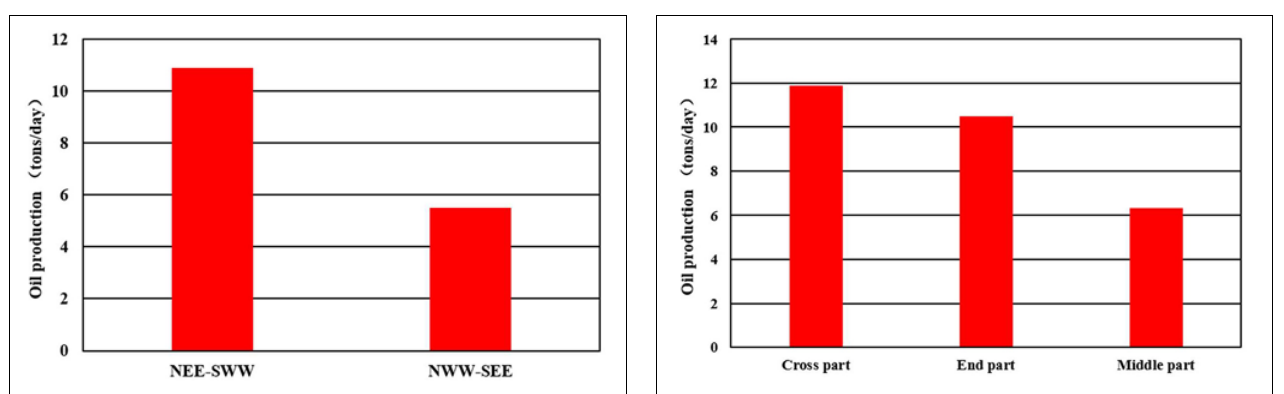
FIGURE 11 | The oil production in the wells drilled different strike of fault.